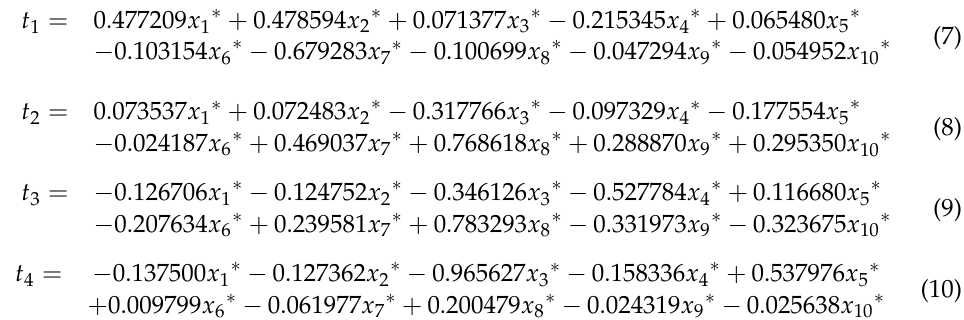
Table 1. Regression coefficients and characteristic values of seepage statistical models.